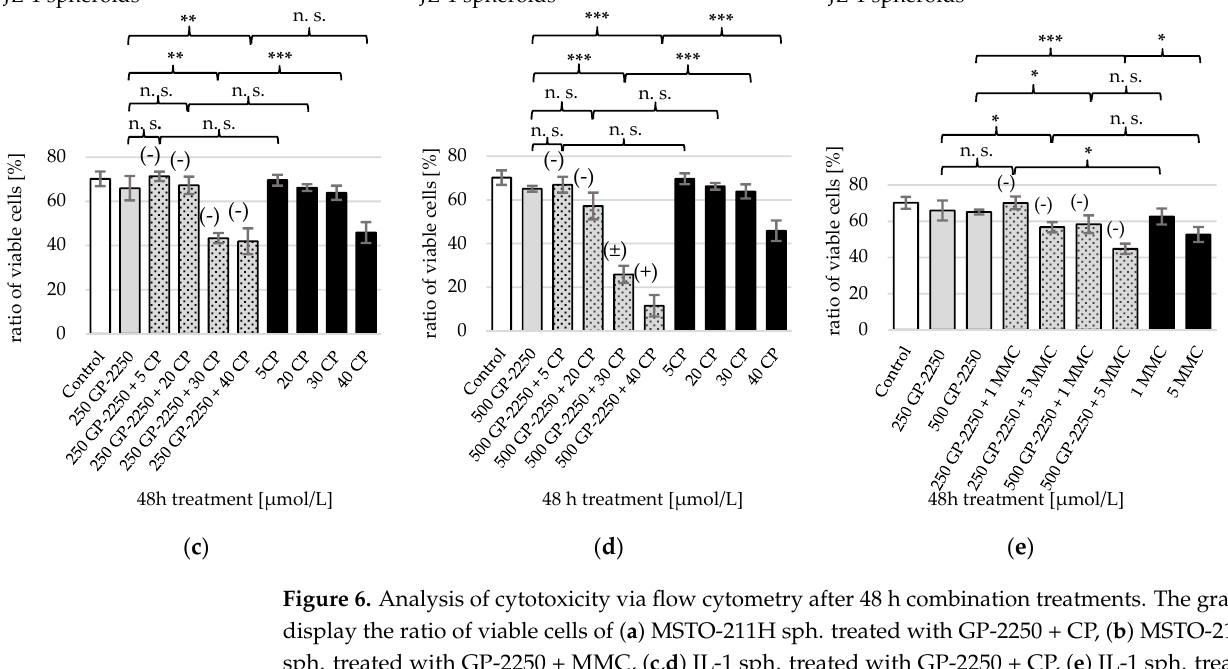
Figure 6. Analysis of cytotoxicity via flow cytometry after 48 h combination treatments. The graphs display the ratio of viable cells of ( a ) MSTO-211H sph. treated with GP-2250 + CP, ( b ) MSTO-211H sph. treated with GP-2250 + MMC, ( c , d ) JL-1 sph. treated with GP-2250 + CP, ( e ) JL-1 sph. treated with GP-2250 + MMC. Cells were marked with annexin V-FITC/ PI dual-binding, following the measurement of viable, apoptotic and necrotic cells via flow cytometry. Values are means ± SD of at least 3 independent experiments with consecutive passages. Asterisk symbols indicate the statistical significance between the combination-treatment and their respective monotherapies. *** p ≤ 0.001, ** p ≤ 0.01, * p ≤ 0.05, n.s. p > 0.05 (unpaired t-test). The combination indices (CI) by Chou-Talalay are marked as followed: CI < 0,9: symbiotic effect (+), CI = 0.9–1.1: additive effect ( ± ) and CI >